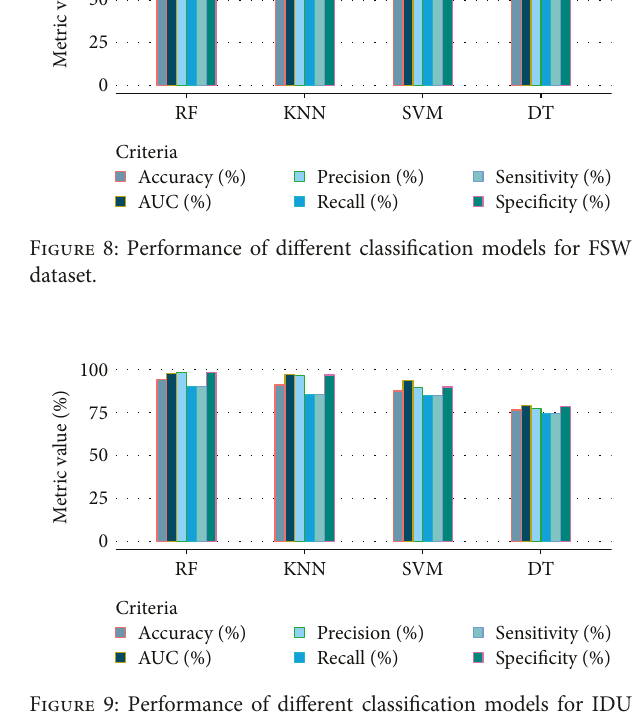
Figure 4: ROC curve of di ff erent classi fi ers for MSM dataset.